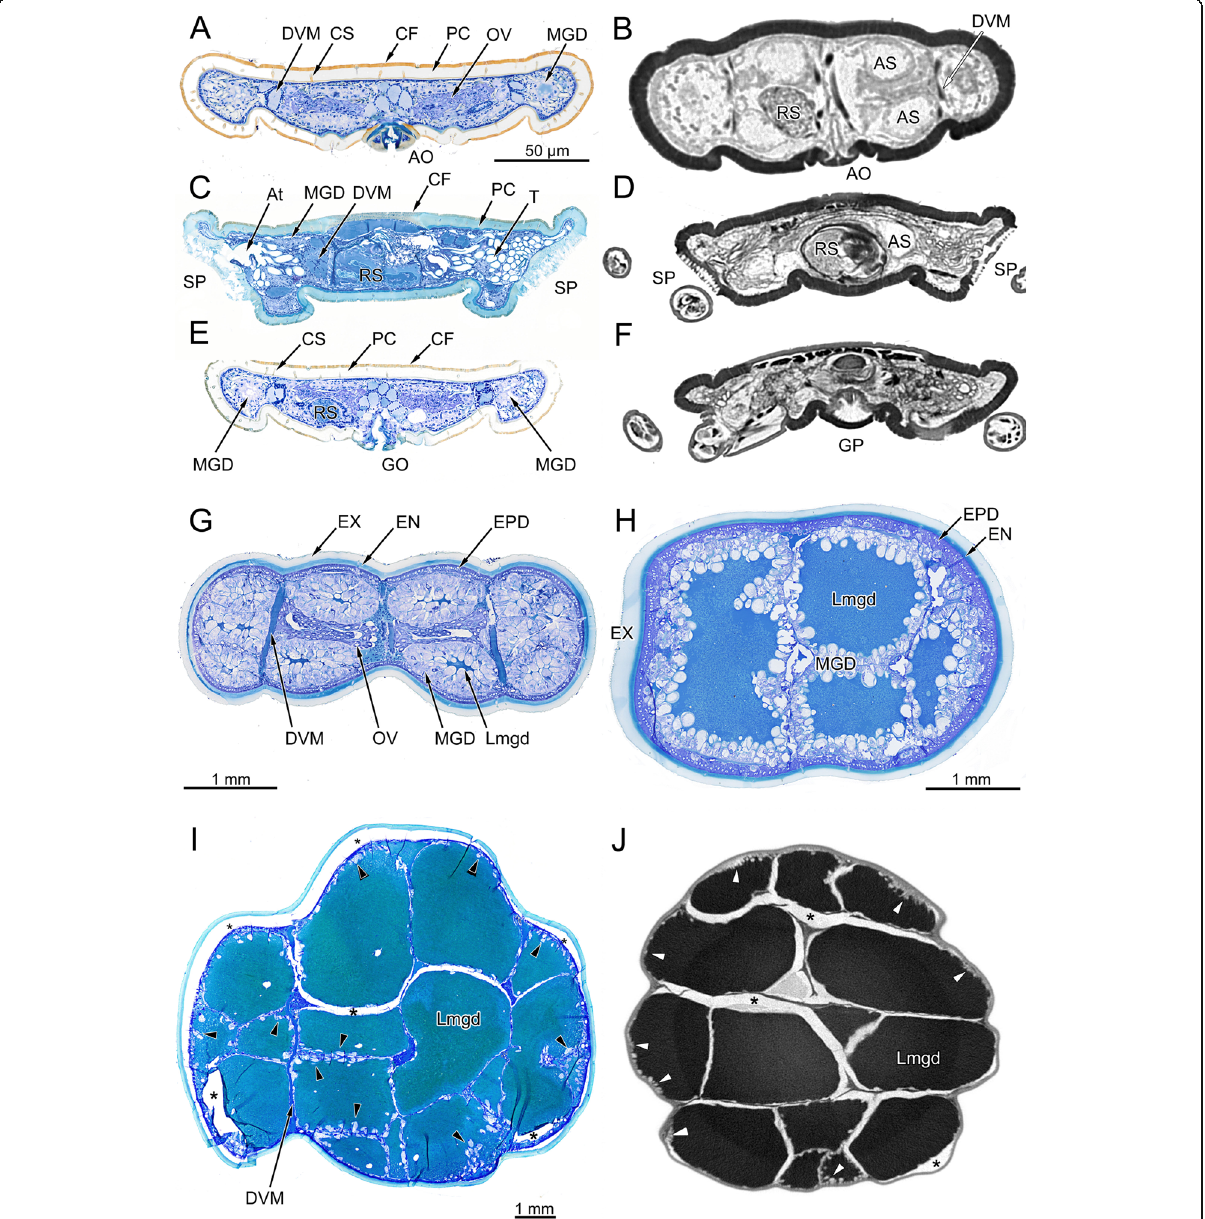
Fig. 2 Ixodes ricinus , microscopic anatomy of fasting, semi-engorged, and fully engorged females. The plate contrasts micrographs of histological cross-sections with μ CT-images. a Histological micrograph of a cross-section at the level of the anal opening. b Grey-level inverted μ CT-image at same position as in ( a ). c Histological micrograph of a cross-section at the level of the spiracular plates. d Grey-level inverted μ CT-image at same position as in c . e Histological micrograph of a cross-section at the level of the genital opening. f Grey-level inverted μ CT-image at same position as in e . Figures a , c , e are from same individual as in Fig. 1b. g Semi-engorged female (previous feeding stage as compared to H), histological micrograph of a cross-section in the posterior region of the opisthosoma, same individual as Fig. 1d. h Semi-engorged tick, histological micrograph of a cross-section in the posterior region of the opisthosoma. i Fully engorged tick, histological micrograph of a cross-section in the posterior region of the opisthosoma. j Grey-level inverted μ CT-image at same position as in “ i ” . Abbreviations: AO, anal opening; AS, anal sac; At, atrium; CF, cuticular folds; DVM, dorso-ventral musculature; EN, endocuticula; EPD, epidermis; EX, exocuticula; GO, genital opening; GP, genital plate; Lmgd, lumen of a midgut diverticulum; MGD, midgut diverticulum; OV, ovary; PC, procuticle; RS, receptaculum seminis; SP; spiracular plate; T, tracheae. Arrowheads in “ i ” and “ j ” point to the digestive cells of the midgut epithelium. Figures a – f same